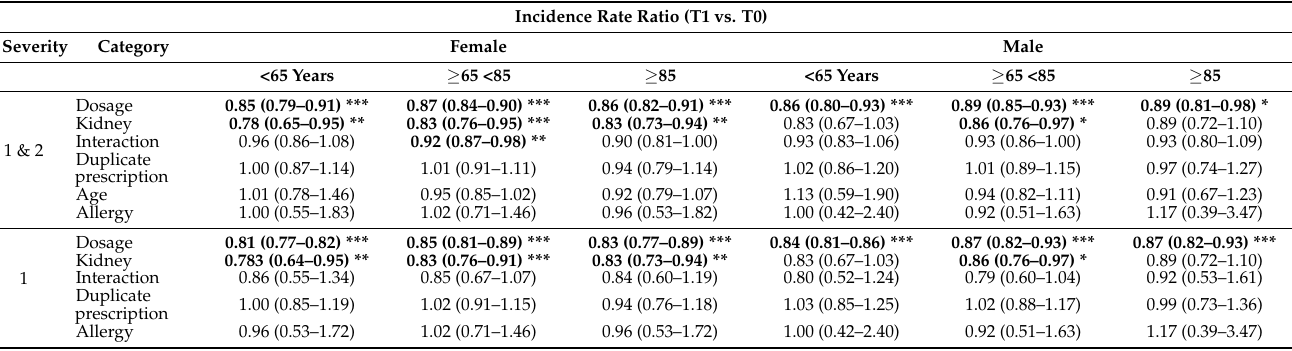
Table 6. Incidence rate ratio of unjustified alerts before and after the intervention, stratified by age, sex, alert category, and severity